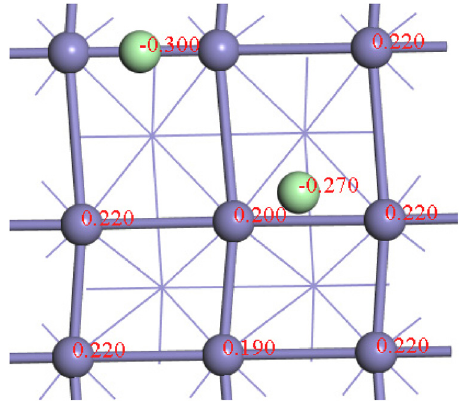
Figure 5: Atomic charges ( in e ) at selected atoms in the B ( 0.5 ML ) con fi guration.